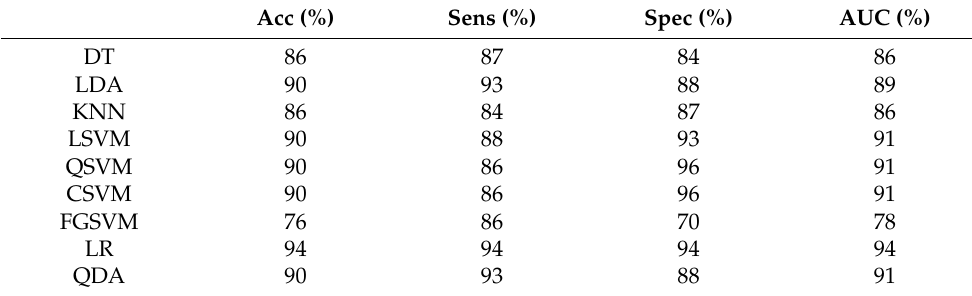
Table 6. Results for the LSDL for Dataset 2.